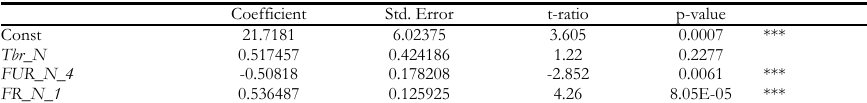
OLS in Northern regions of Italy (adj. R 2 =